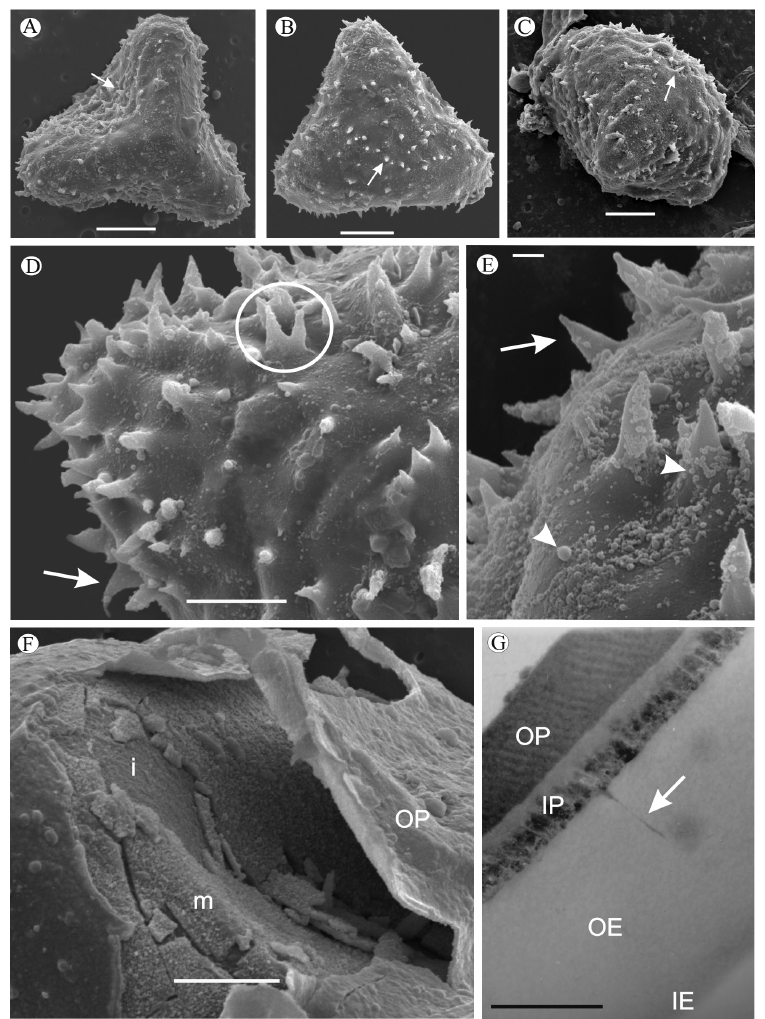
Fig. 1 – Spores of Sphaeropteris gardneri as seen with SEM and TEM. A-F. SEM micrographs. A. Spore in proximal view. The ornamentation is composed of low-ridges with few spines on their margins (arrow). The laesurae margins are smooth. Scale bar: 10 μ m. B. Spore in distal view. Low-ridges with scattered spines on their margins are shown (arrow). Scale bar: 10 μ m. C. Spore convex-hemispheric in equatorial view. The ornamentation is composed of low-ridges with spines on their margins (arrow). Scale bar: 10 μ m. D-E. Details of the distal surface that show conic spines (arrow). In some cases, two spines are fused by their bases (circle, in Fig. D). Spheroids of different diameters are seen on the surface (arrowheads, in Fig. E). Scale Bars: Fig. D, 5 μ m; Fig. E, 1 μ m. F. Fracture of the sporoderm as seen with SEM. It shows the outer perispore layer (OP), and the inner (i) and medium (m) stratum of inner perispore. Scale bar: 5 μ m. G. The sporoderm as seen in section with TEM. This figure shows the stratification of the walls and a channel (arrow) within the exospore. IE: inner exospore; OE: outer exospore; IP: inner perispore; OP: outer perispore. Scale bar: 1 μ